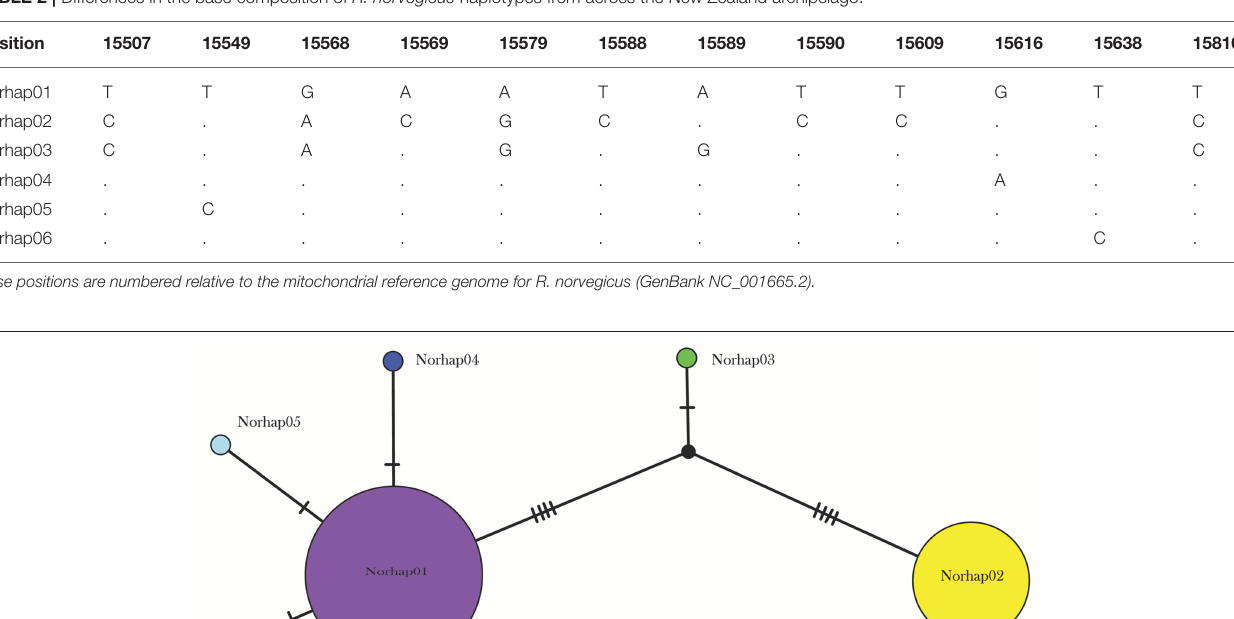
and Rathap07 was found in Stewart Island and neighboring islands ( Figure 6